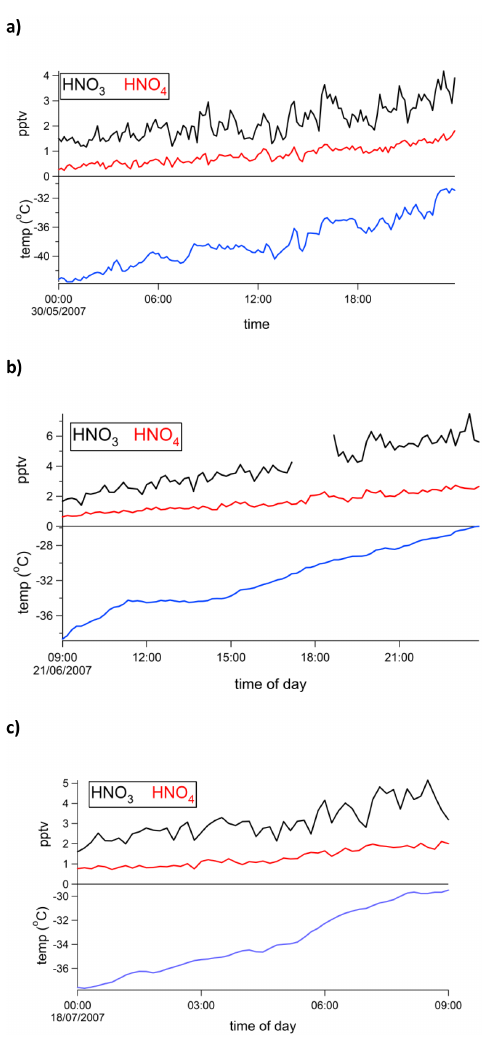
Figure 6. Detail of changes in HNO 3 , HO 2 NO 2 and temperature on (a) 30 May, (b) 21 June, and (c) 18 July. These three periods in the measurement series were characterised by low and invariant wind speeds and 24h per day darkness.